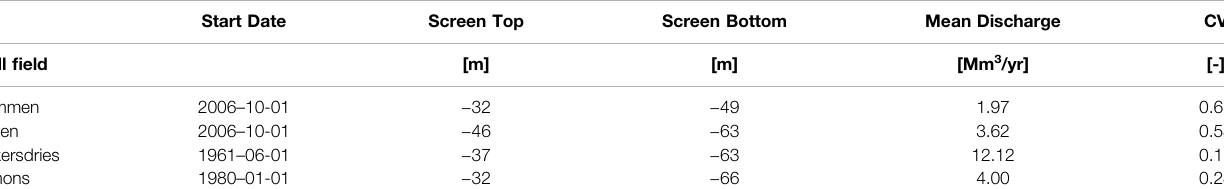
screen 5 of well B39F0579 (located in aquifer 2) are shown in the top graph of Figure 5 . A clear decrease in head is visible from 2007 onwards, which coincides with the start of pumping. A